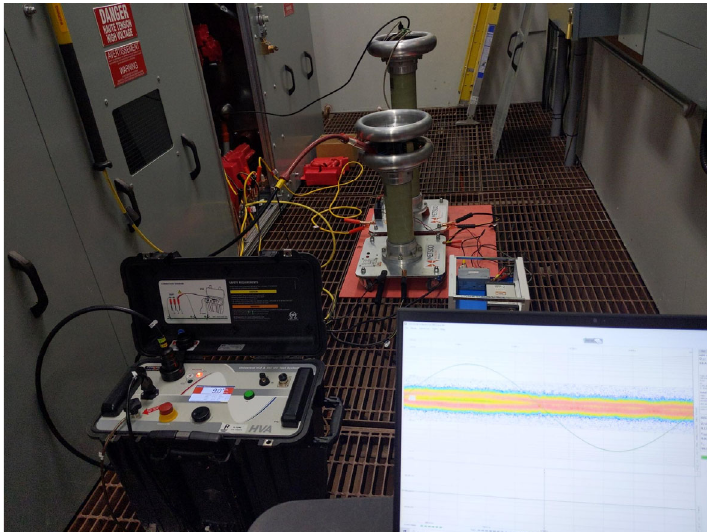
Figure 6. Simultaneous VLF Tan-Delta and PD Measurement Setup.